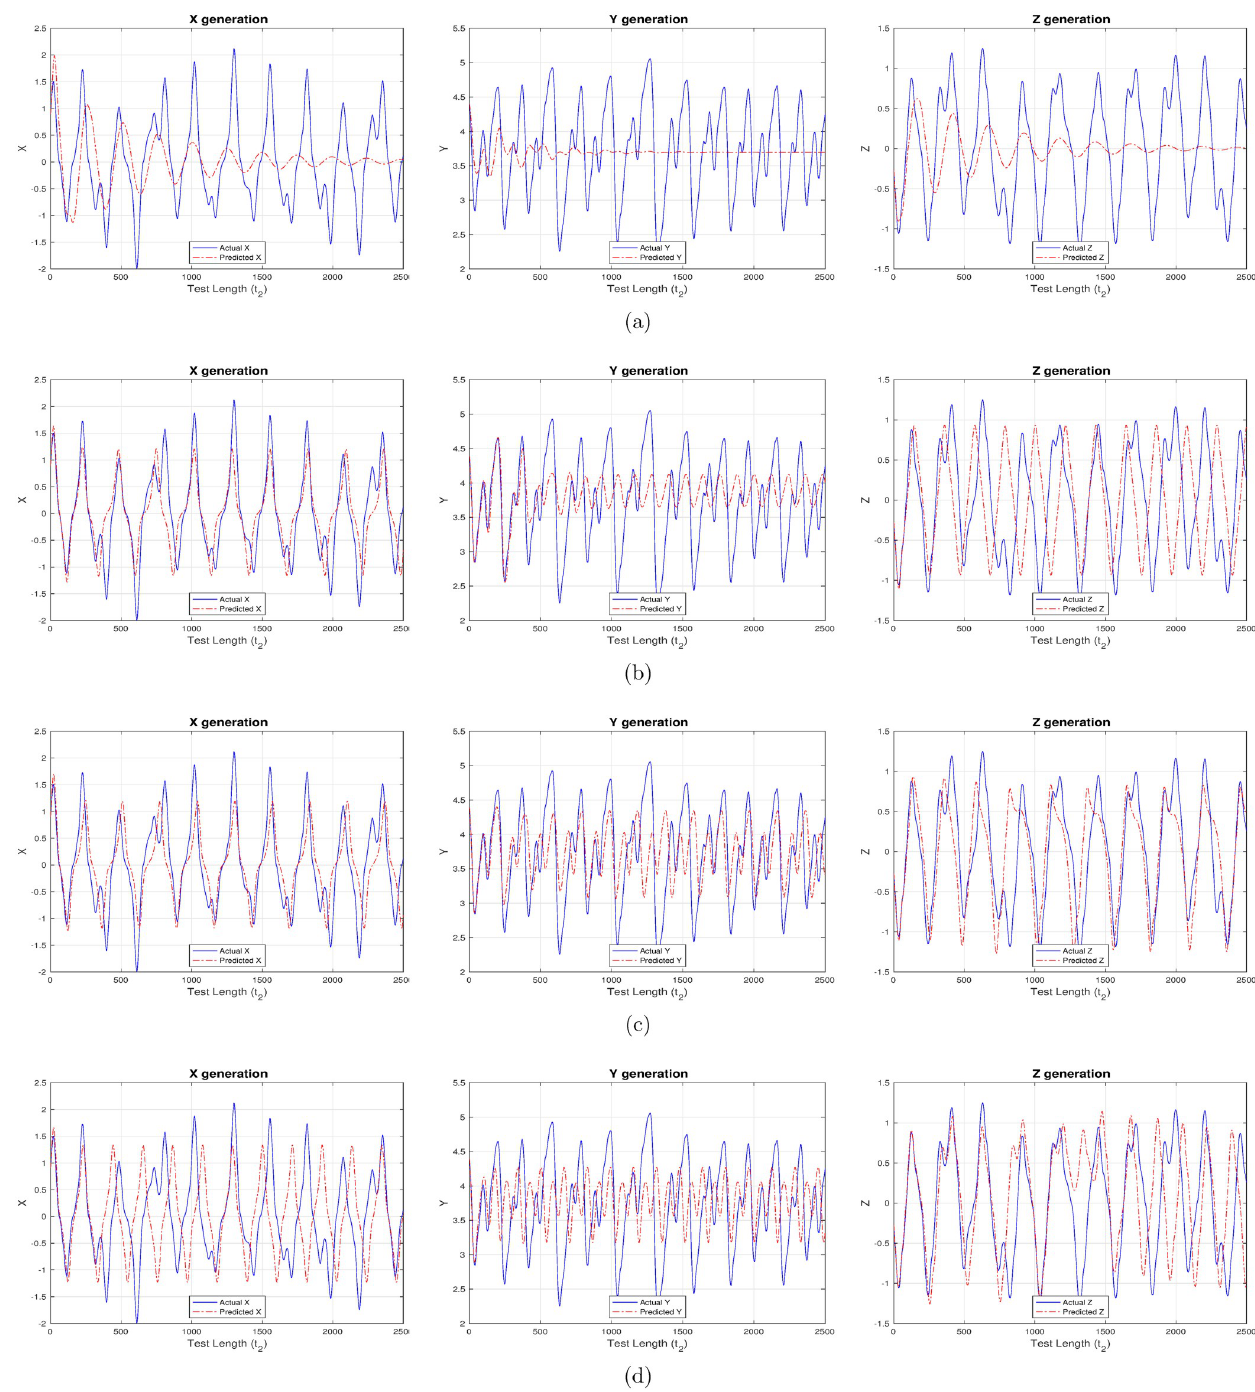
Fig 2. Predicting the chaotic financial system behavior using different activation functions. (a) linear activation (b) strictly non-linear activation (c) quadratic activation (d) tanh activation.